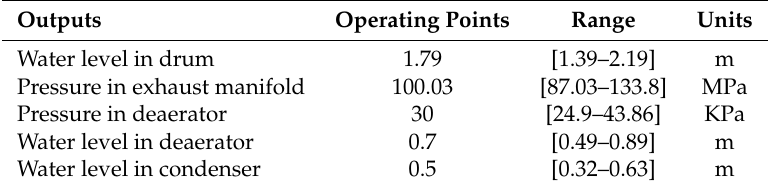
Table 1. The operating points and range of the steam/water